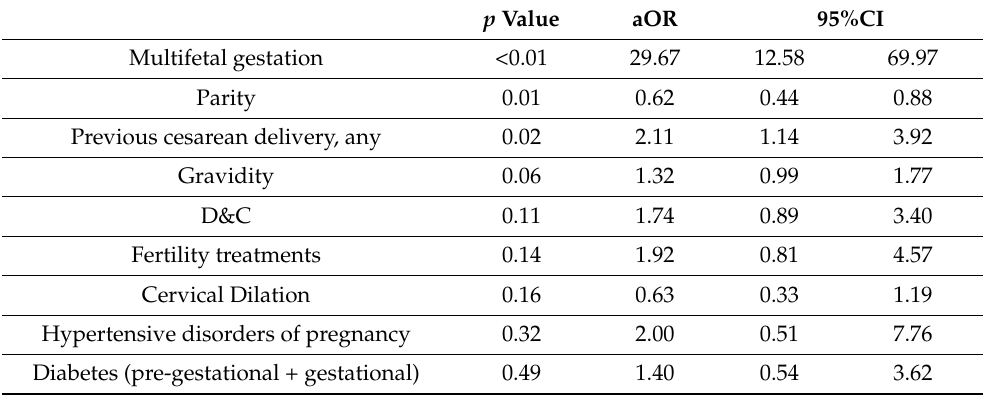
Table 3. Multivariate logistic regression analysis for the association between the mode of uterine evacuation and preterm delivery in the subsequent delivery (Adjusted Odds